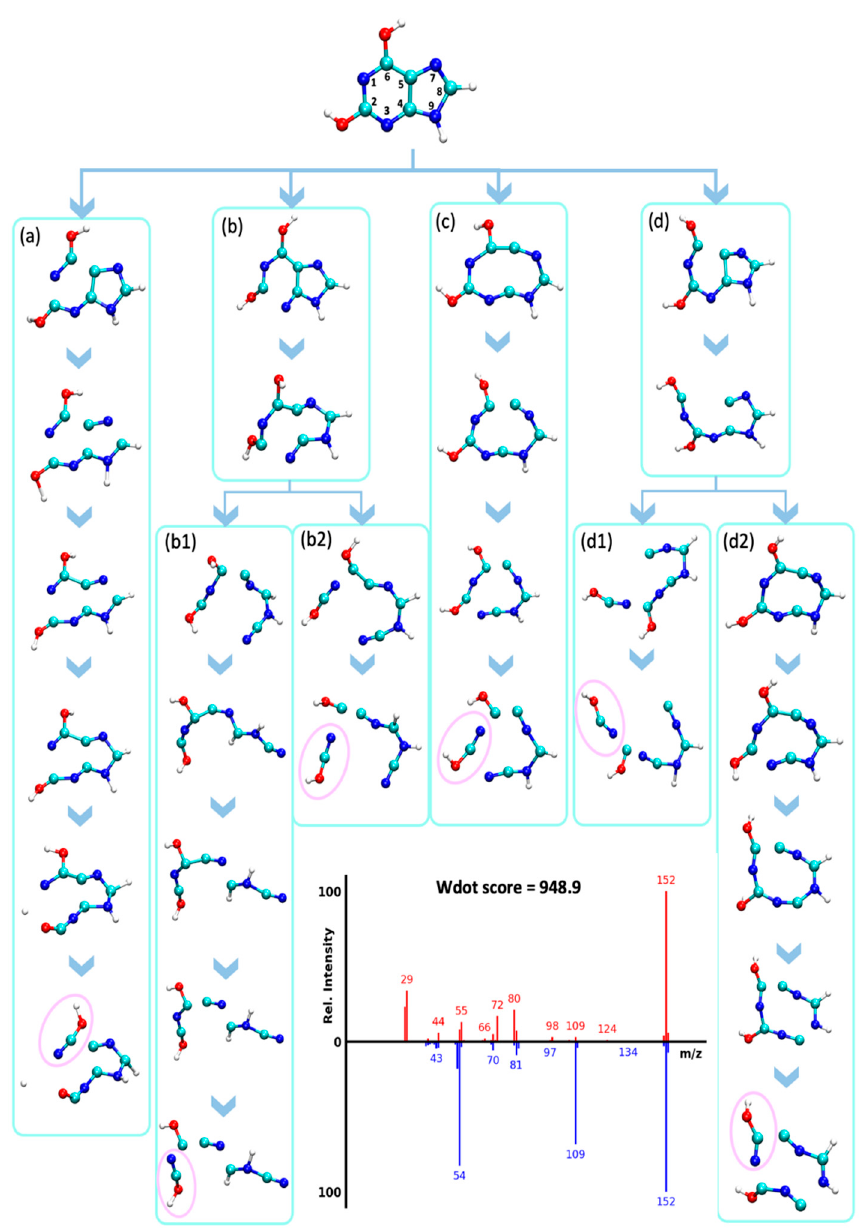
Figure 7. Analysis of QCEIMS trajectories for xanthine marking multiple dissociation pathways ( a – d ) to lose isocyanic- or cyanic acid (HNCO/NCOH, 43 u, noted by pink circles). Note: none of the trajectories predicted the direct neutral loss of 43 u from the molecular ion to yield m/z 109. Mass spectrum insert: Top : QCEIMS, bottom : experimental spectrum.